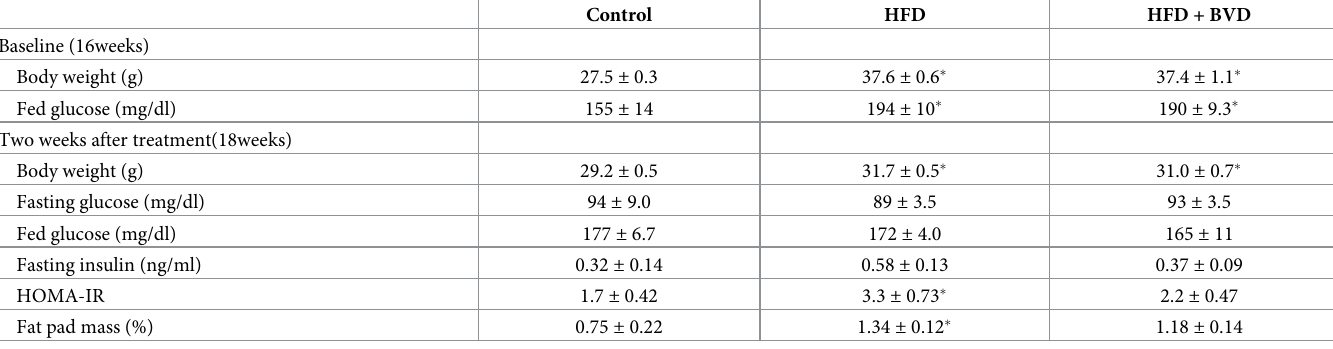
Table 3. Effects of high-fat diet and biliverdin on body mass and metabolic indices in mice.